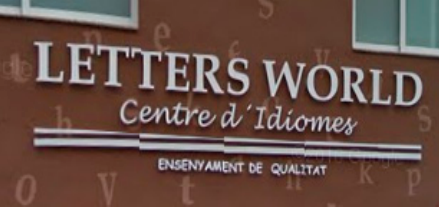
Figure 31. Almazora: Bilingual sign on a stationery shop .